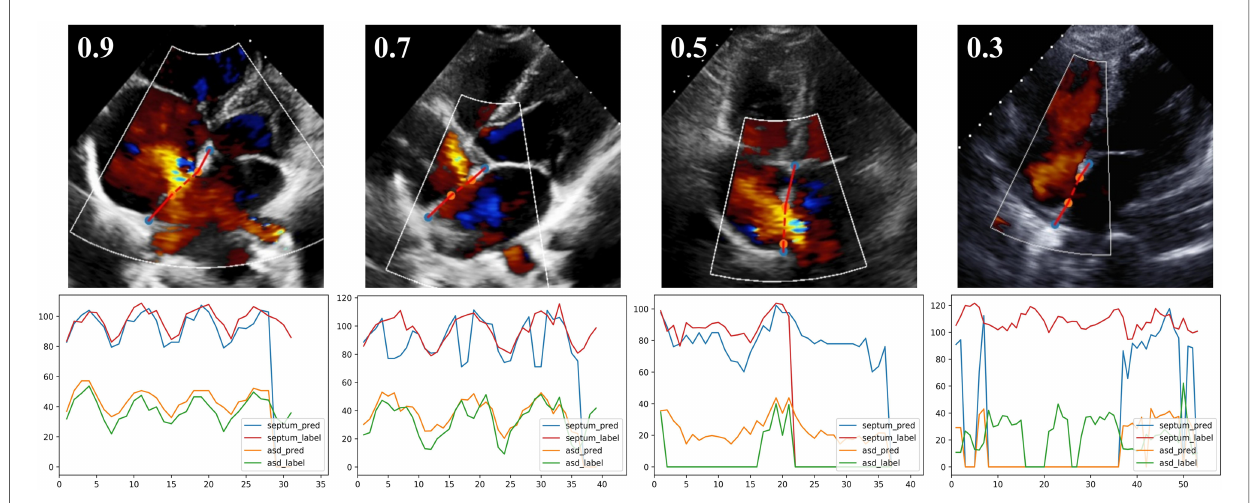
FIGURE 6 The output of quanti fi cation model with different con fi dence levels. The fi rst row, one example test image of A4C view is shown respectively with the con fi dence of 0.9, 0.7, 0.5 and 0.3. The second row, corresponding curves showing the variation of defect and septum in the video.